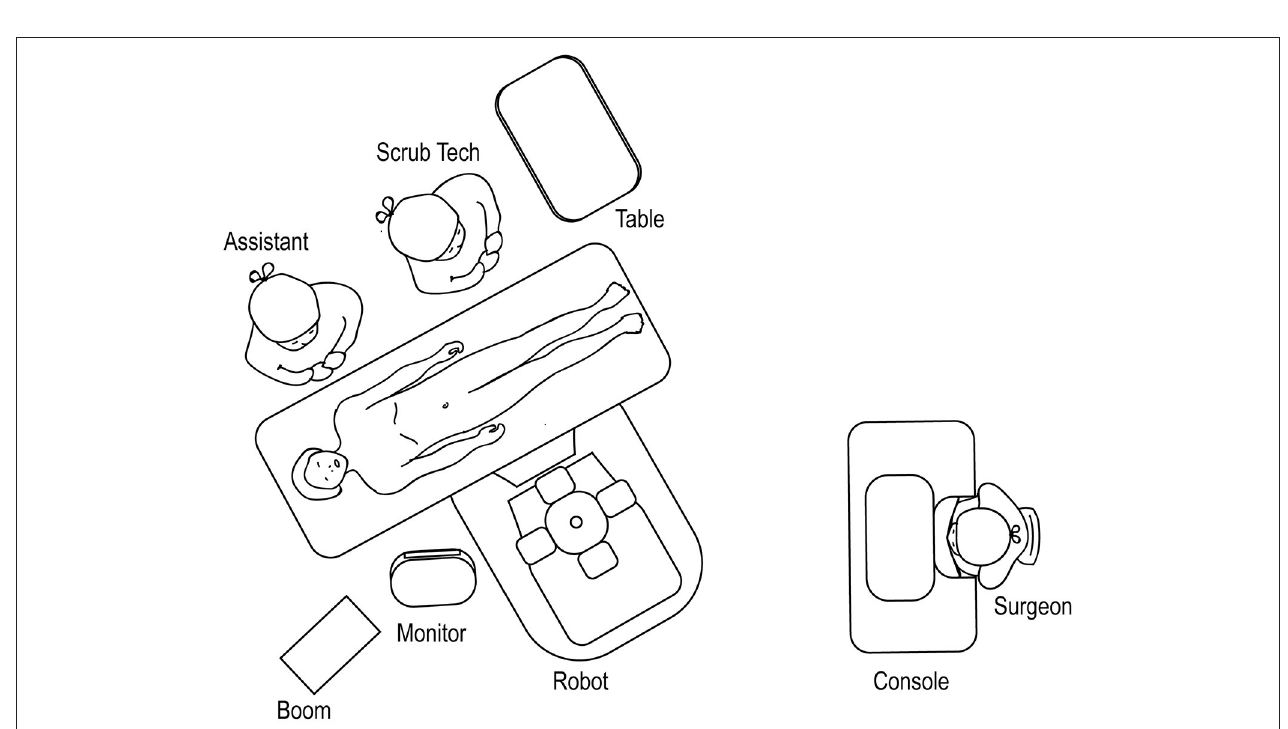
FIGURE 15 | Overhead view of room set-up for lower urinary tract surgery in the supine position.